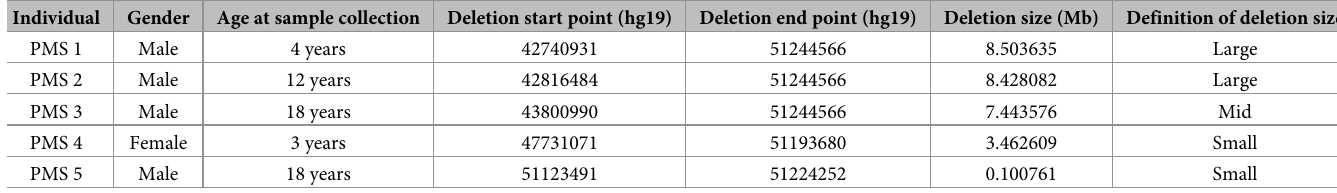
Five individuals with PMS (four males and one female, 3 from the cohort of 81 and two unre- lated patients) were selected because of their diverse cytogenetic features for expression analy- sis and available lymphoblastoid cell lines (Table 1). Terminal deletions were confirmed independently by FISH and MLPA. Table 1. Selected individuals with PMS for expression and metabolic